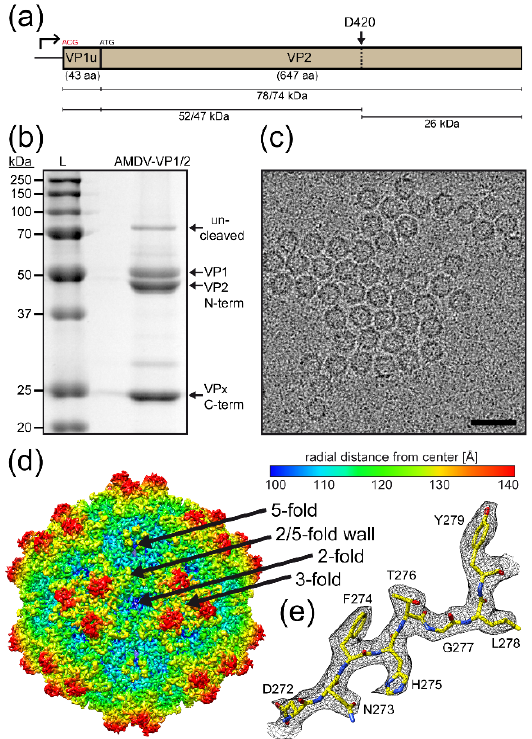
Figure 2. Determination of the AMDV capsid structure. ( a ) Depiction of the AMDV-VP1/2 expression construct. A cleavage of the AMDV VPs at D420 has been described previously [28]; the results for the VP1 and VP2 fragments as shown below. ( b ) SDS-PAGE of purified AMDV VLPs with bands at ~75, 52, 47, and 25 kDa equivalent to the size of uncleaved VP2, the N-terminal VP1 and VP2 fragments, and the C-terminal VPx fragment, respectively. ( c ) Example cryo-electron micrograph of AMDV. Scale bar: 500 Å. ( d ) The capsid surface density map contoured at a sigma ( σ ) threshold level of 2.0. The map is radially colored (blue to red) according to distance to the capsid center, as indicated by the scale bar on the right. The approximate icosahedral two-, three-, and five-fold axes are indicated. ( e ) Amino acid residues modeled for the β G strand are shown inside their density maps (in black). The amino acid residues are as labeled and shown as stick representations and colored according to atom type: C = yellow, O = red, N = blue. Panels ( d , e ) were generated using UCSF-Chimera [25].